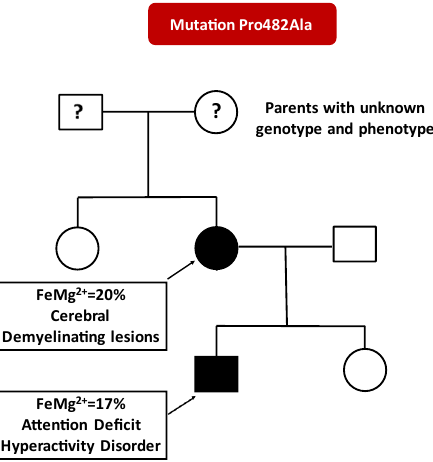
Figure 1. Family tree depicting magnesium fractional excretion (FeMg 2+ ) and main clinical characteristics of affected individuals. Black symbols, affected individuals. White symbols, unaffected individuals.